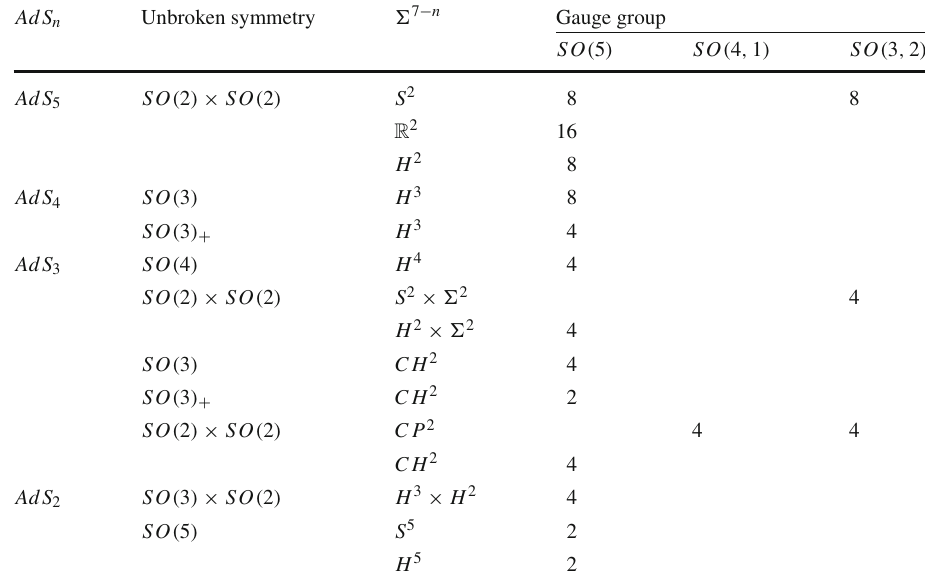
AdS n Unbroken symmetry (cid:2) 7 − n Gauge group AdS 5 SO ( 2 ) × SO ( 2 ) S 2 8 8